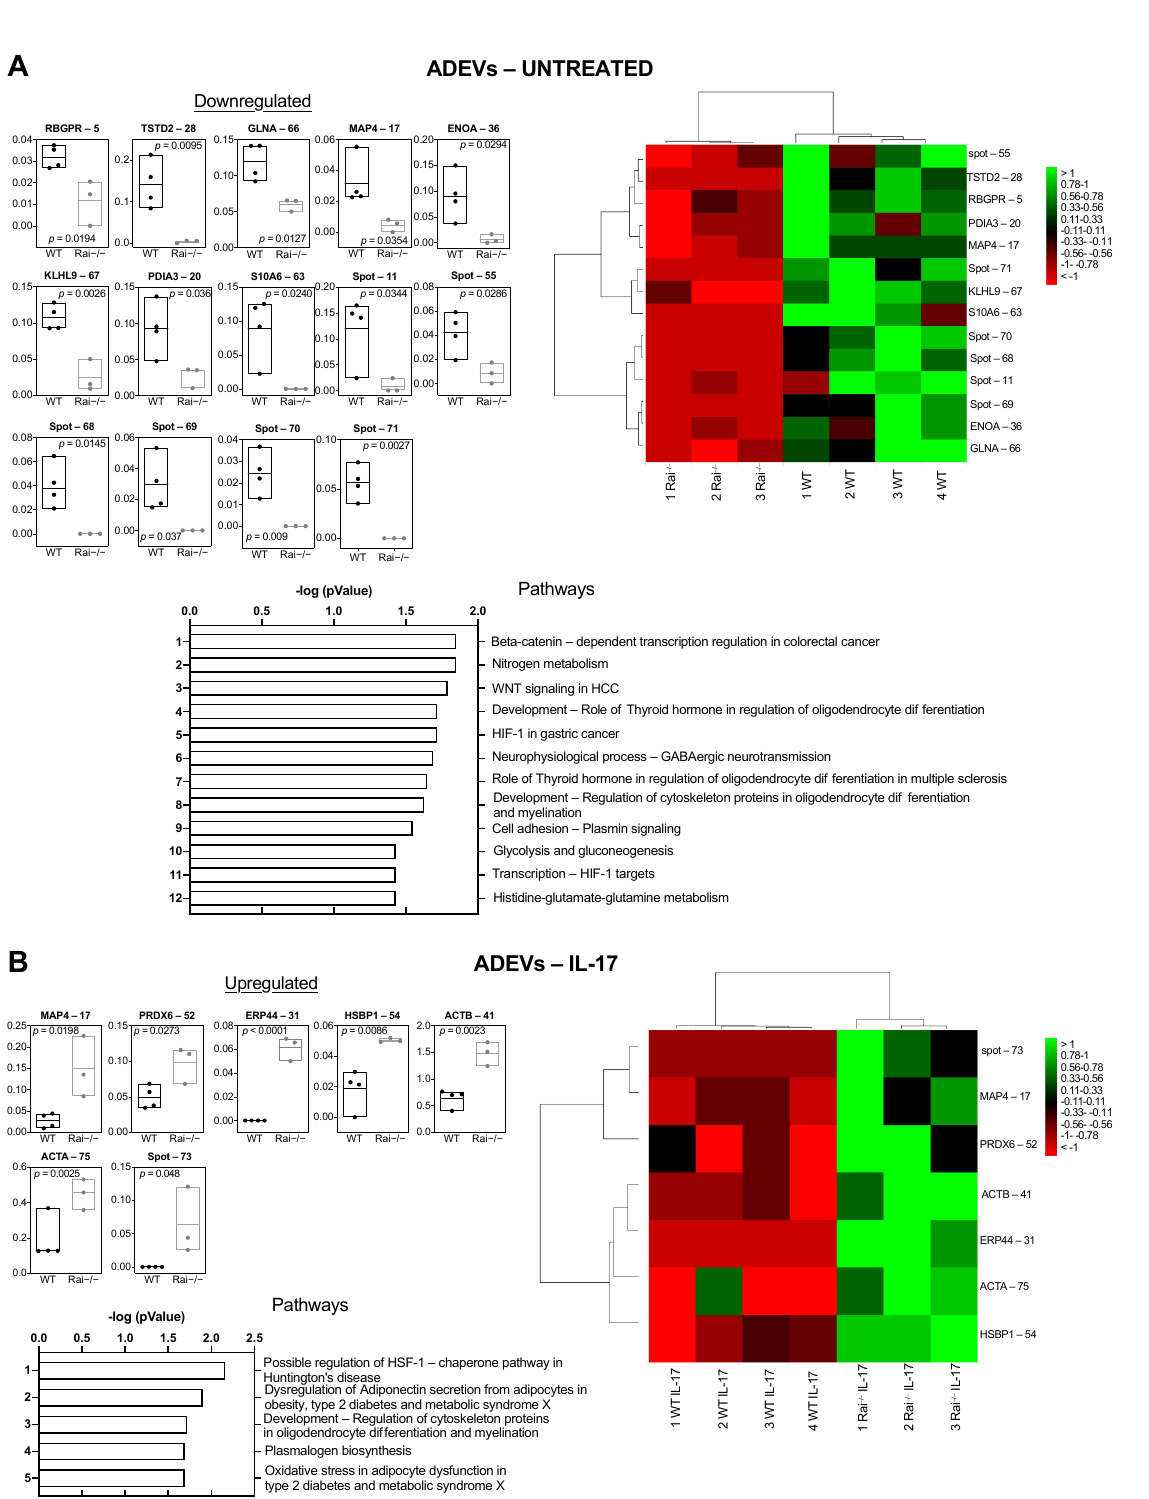
Figure 3. Differential proteomic analysis of control and Rai −/− ADEVs . Supervised hierarchical clustering heat map (left) and floating bars (min to max) (right) of differentially abundant proteins found in ADEVs purified from the cell media of control (WT) and Rai −/− astrocytes untreated ( A ) and treated with IL-17 ( B ) ( n = 4 WT, 3 Rai −/− ). Heat maps: columns correspond to individual preparations of ADEVs and row to spot identity (protein name, or spot number for not identified spots). Color scale (from high value in green to low value in red) illustrates % volume values of the statistically significant differentially abundant spots. The most relevant pathway maps reported by MetaCore, based on all differentially expressed proteins and prioritized according to their statistical significance ( p ≤ 0.001), are shown for each condition.